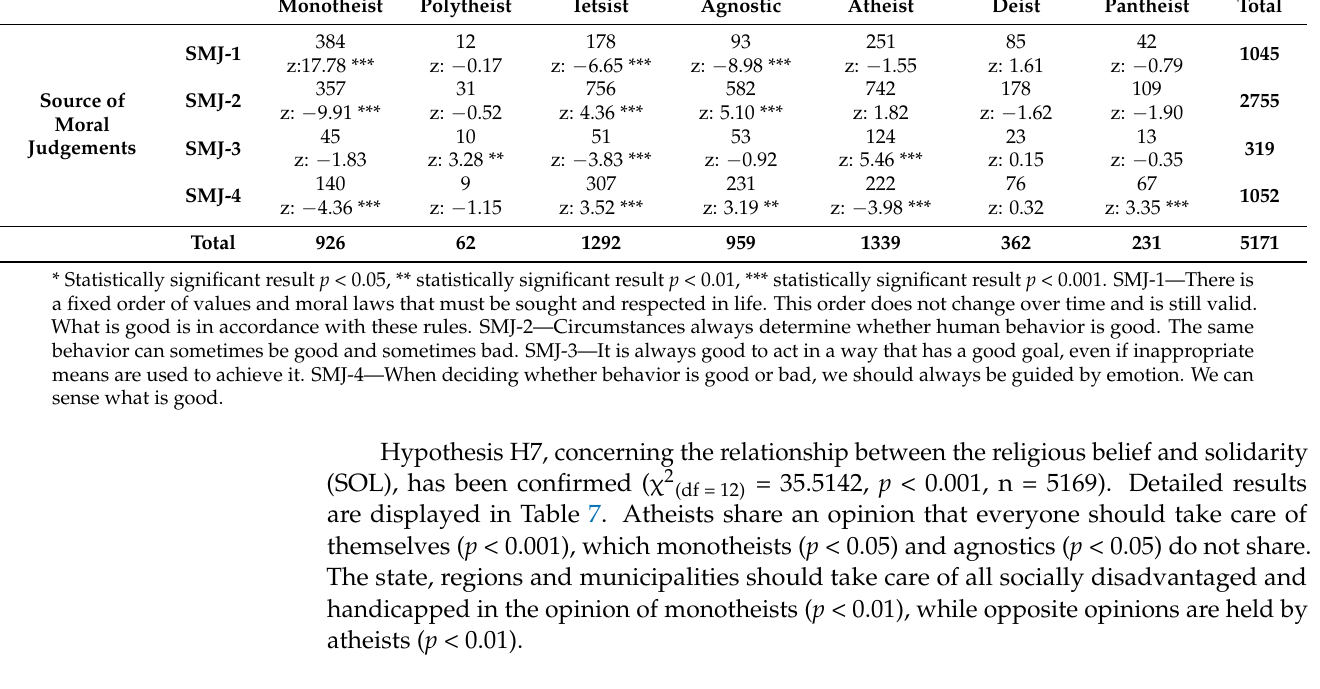
Table 7. Relationship between the religious belief and solidarity